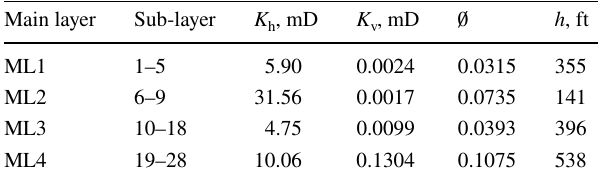
Table 7 Average petrophysical specification of the 4-layer